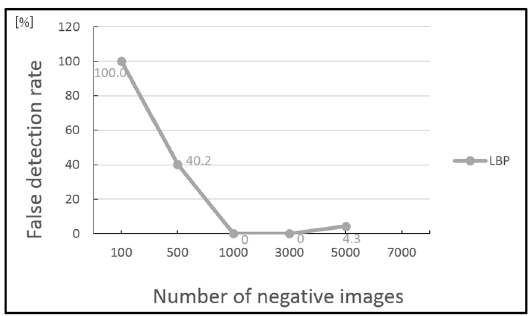
Figure 8. Changes in false detection rate when 200 positive images are used and the number of negative images is increased from 100 to 7000.